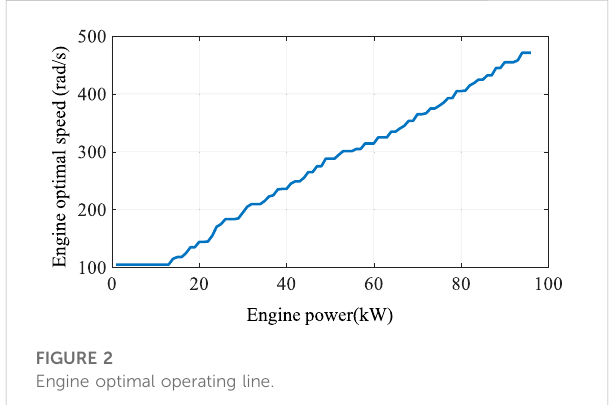
FIGURE 2 Engine optimal operating